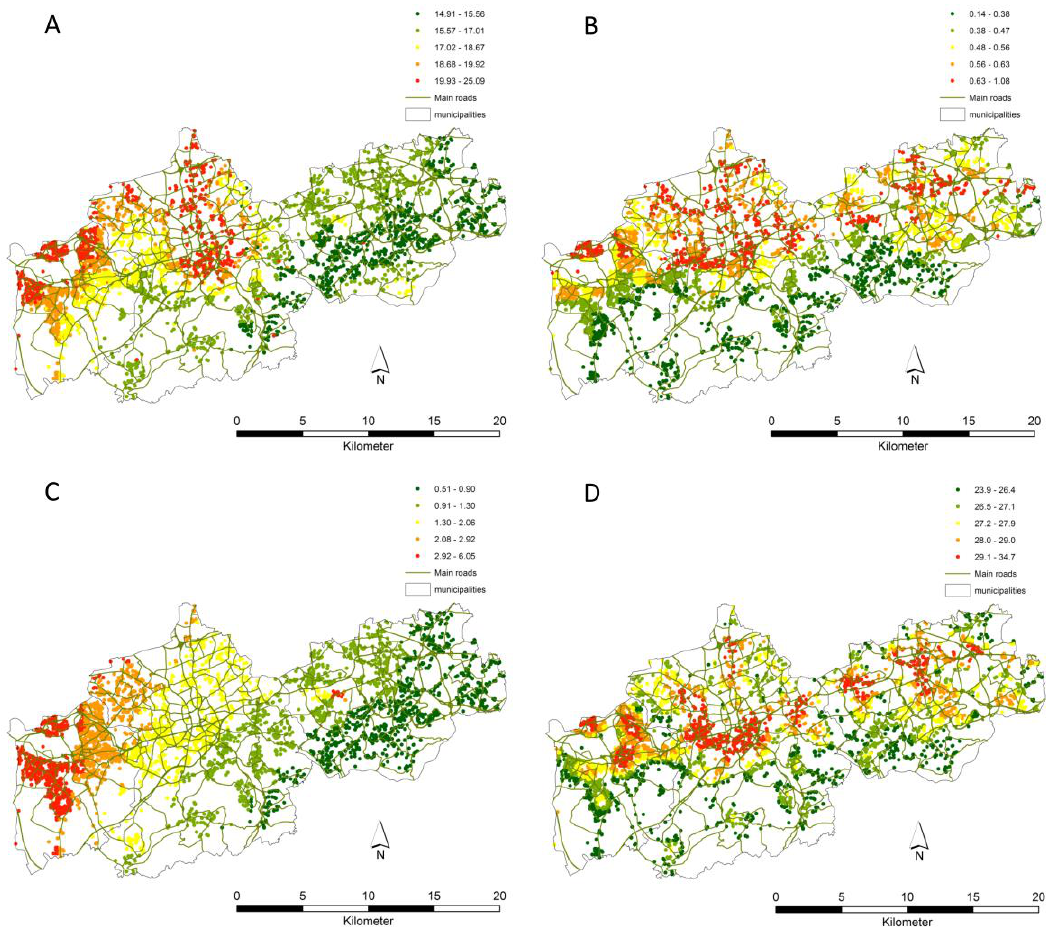
Figure 4. Residence-based spatial distribution of PM 10 concentrations from EURAD-CTM: all-sources ( A ); local traffic ( B ) and local industry ( C ); and ESPCAPE-LUR ( D ).